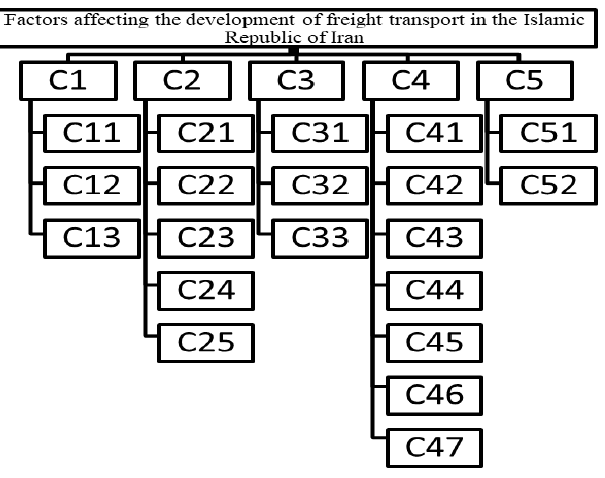
Fig. 2. Hierarchical model of the research (coded).